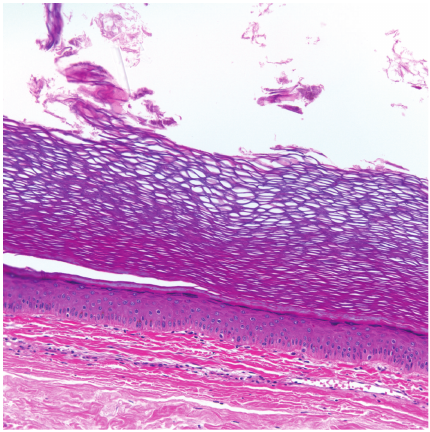
Figure 3: High power view of epidermal inclusion cyst wall demonstrating benign squamous epithelium with keratin forma- tion